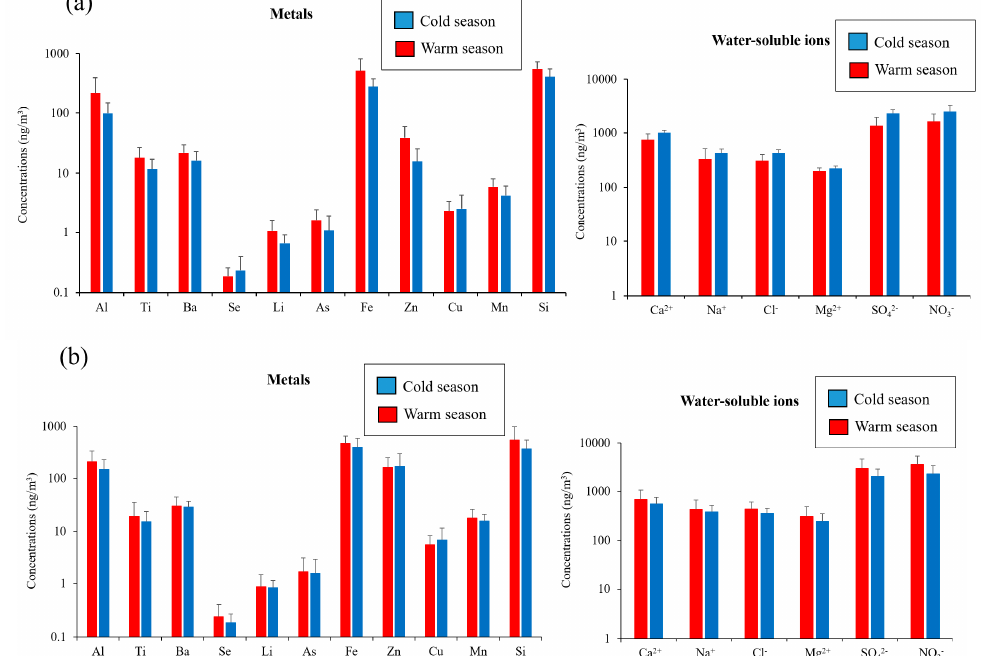
Figure 3. Seasonal variations in the concentrations of selected metals and water-soluble ions at: ( a ) Tohid retirement home; ( b ) school dormitory. Error bars correspond to one standard deviation (SD).